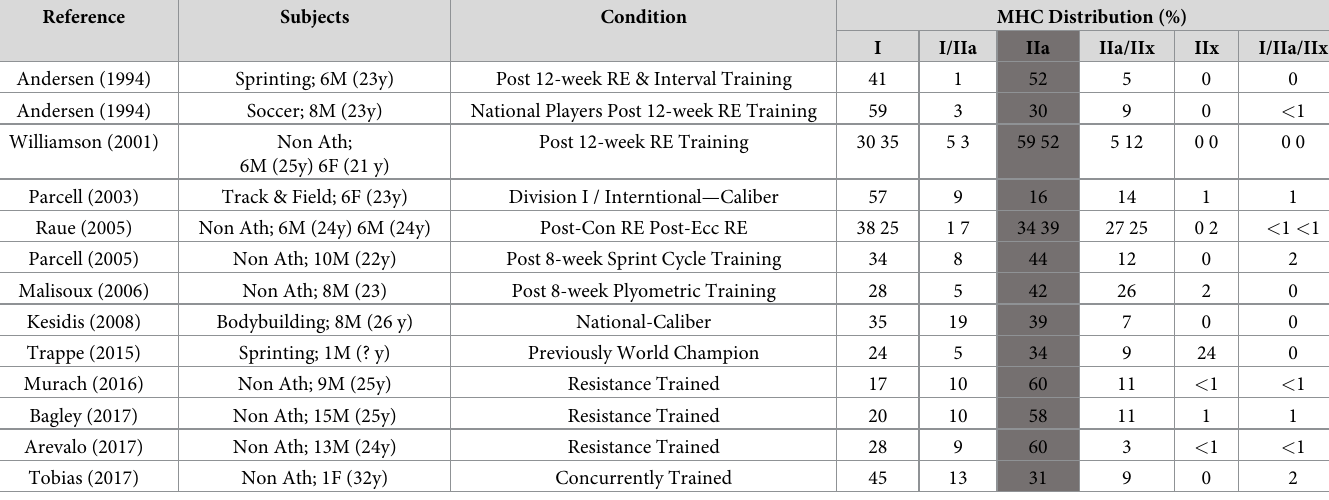
Table 1. Summary of literature reporting SF MHC FT% from the VL in young speed, power, or strength-trained individuals.